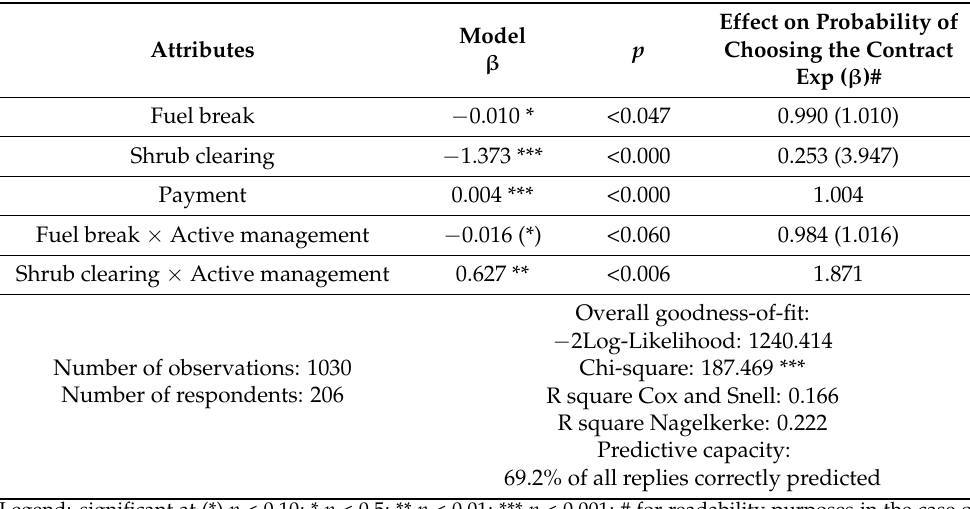
Table 3. Estimated parameters of the binomial logistic regression